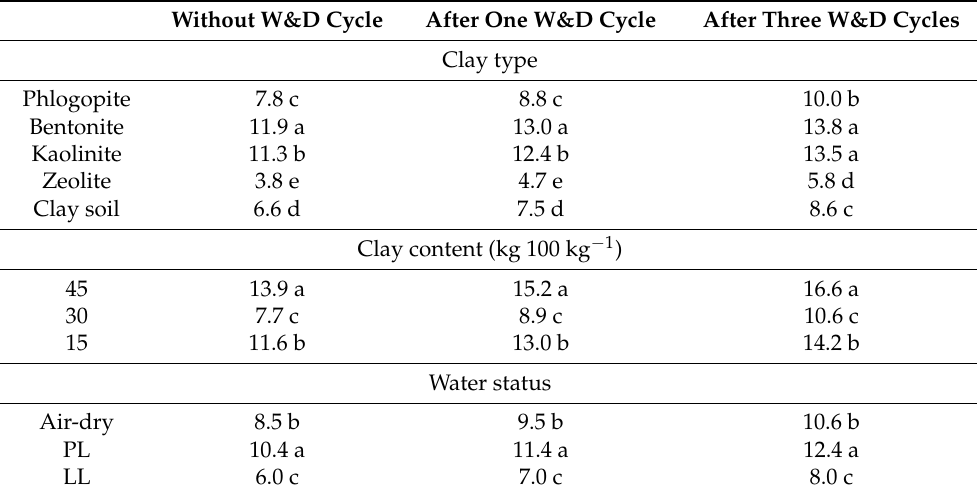
Table 4. Comparisons of the mean effects of treatments on the cohesion (kPa) of the studied clay–sand mixtures and clay